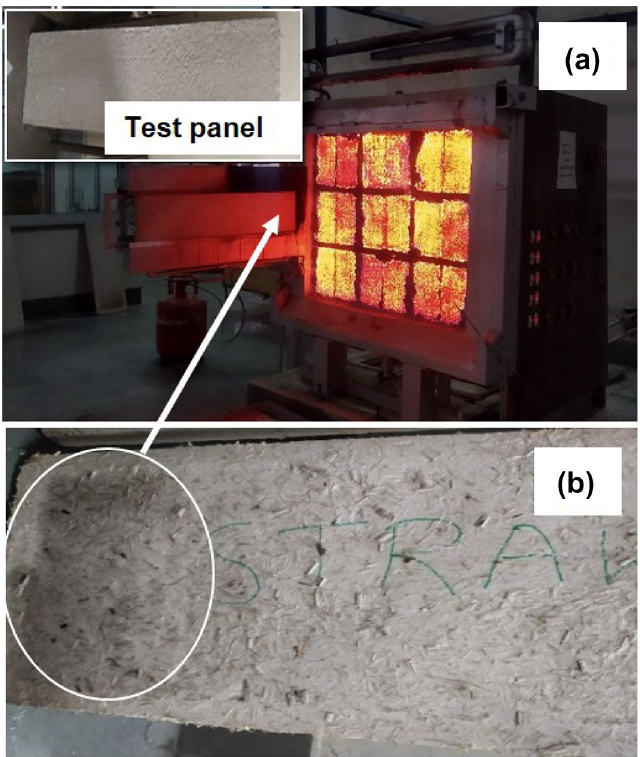
Figure 11. ( a ) Surface spread of flame test on gypsum-agro waste sample, ( b ) surface feature of agro-waste gypsum sample tested for surface spread of flame.